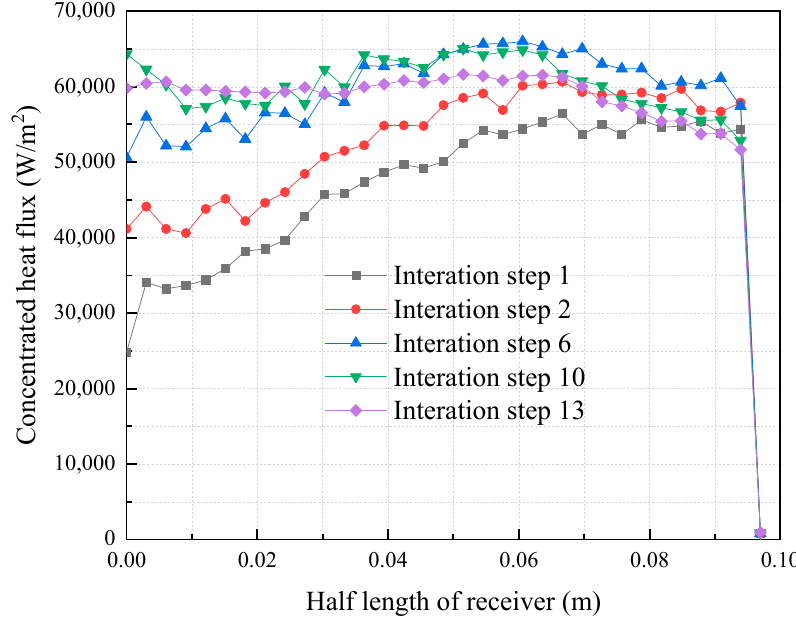
from the target heat flux 60 kW/m 2 , especially for the central region of the receiver. With becomes closer to the target value. closer to the target value.